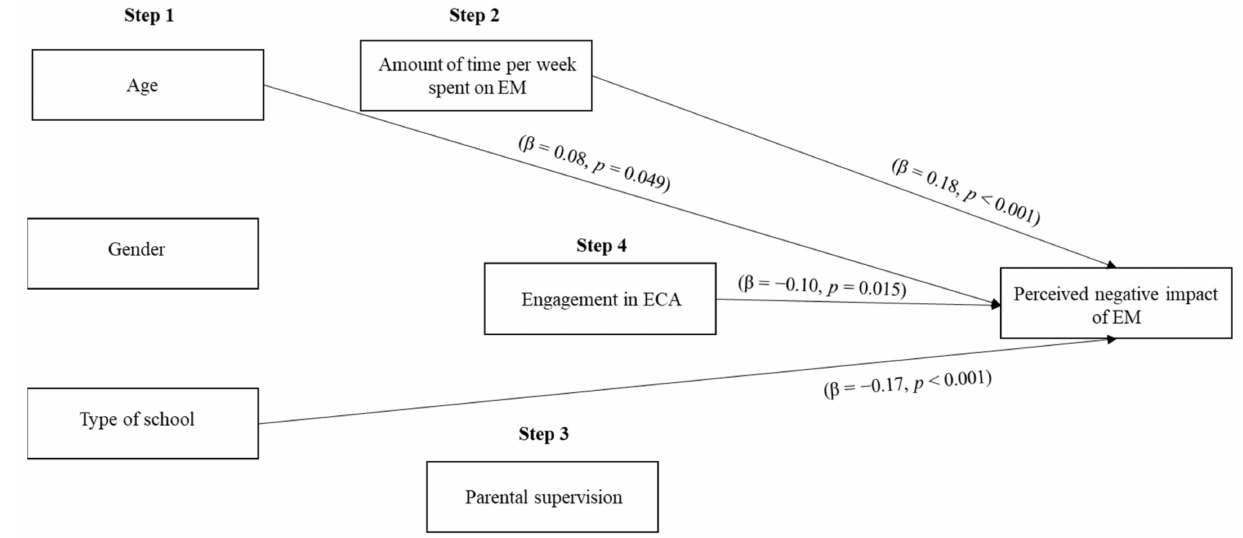
Figure 1. Predictors of perceived negative impact of EM (youth’s